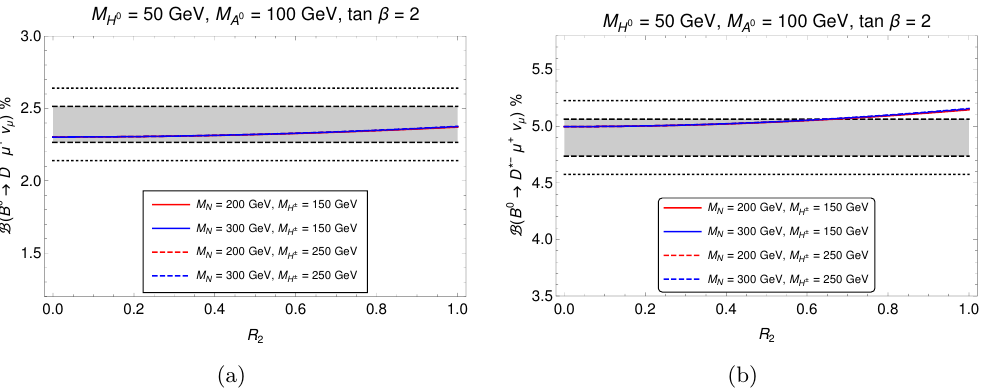
each. The other relevant parameters H ±